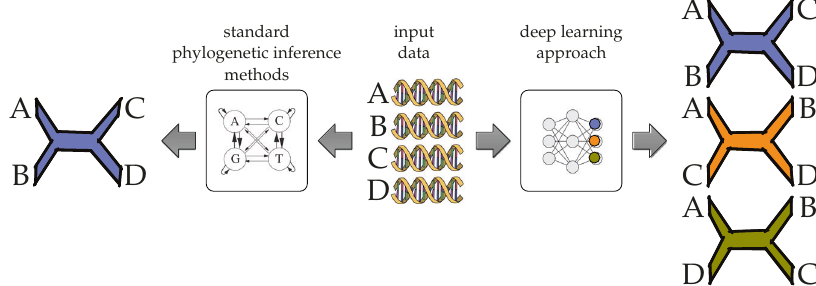
Fig. 3 Standard and DL approaches to phylogenetic inference. The input consists of sequences (DNA sequences in this illustration) obtained from the taxa of interest. Here, the taxa are A, B , C , and D . In standard approaches, such as maximum likelihood and maximum parsimony, a generative model in the form of a tree whose leaves are labeled by the four taxa is inferred. In the recently introduced DL approach to phylogenetic inference, the problem is viewed as a classi fi cation task where the network outputs correspond to the three possible tree topologies whose leaves are labeled by the taxa A , B , C , and